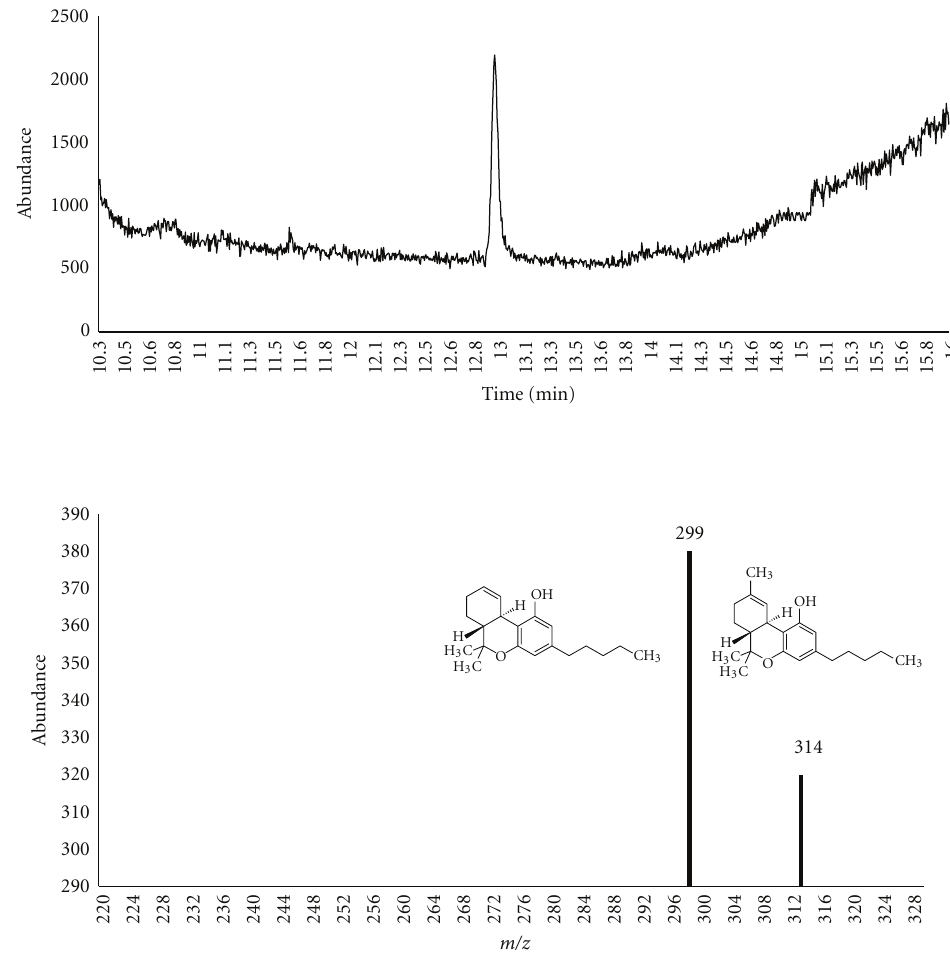
Figure 1: GC-MS chromatogram and fragmentation pathway of Δ 9